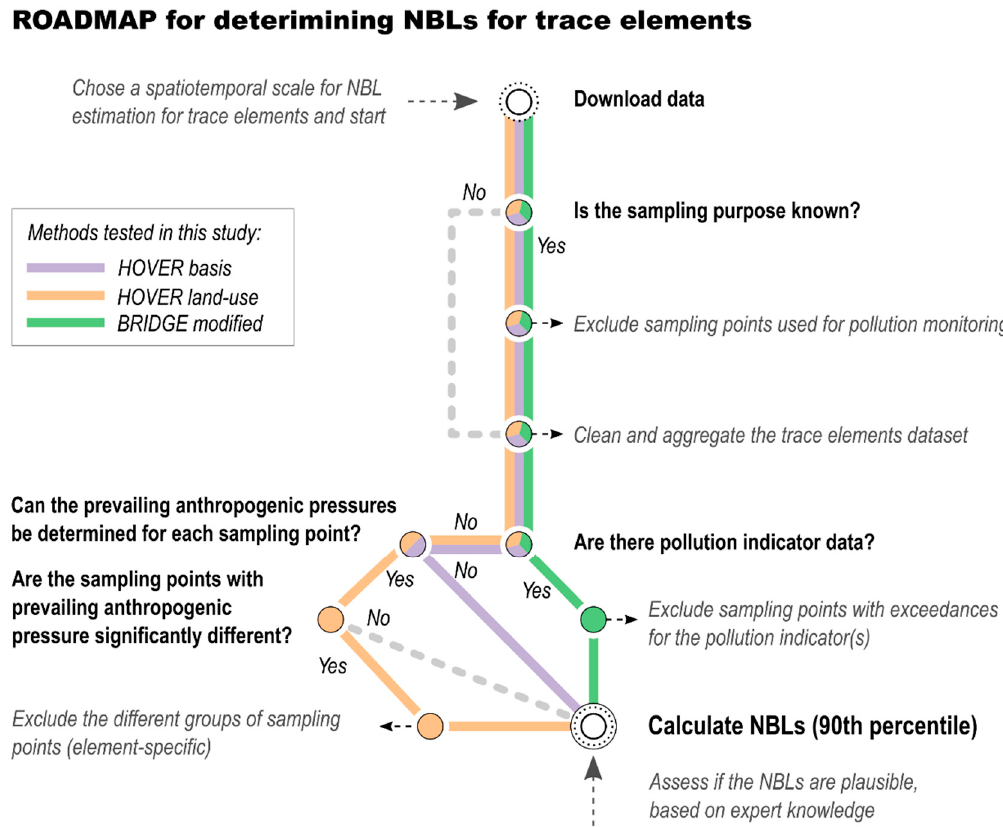
Figure 10. Roadmap for determining natural background levels (NBLs) for trace elements showing the different steps in the data analysis based on data availability; the 3 methods for excluding anthropogenic influences that were tested in this study are also mapped.